Question: In a single sentence, describe what this figure presents.
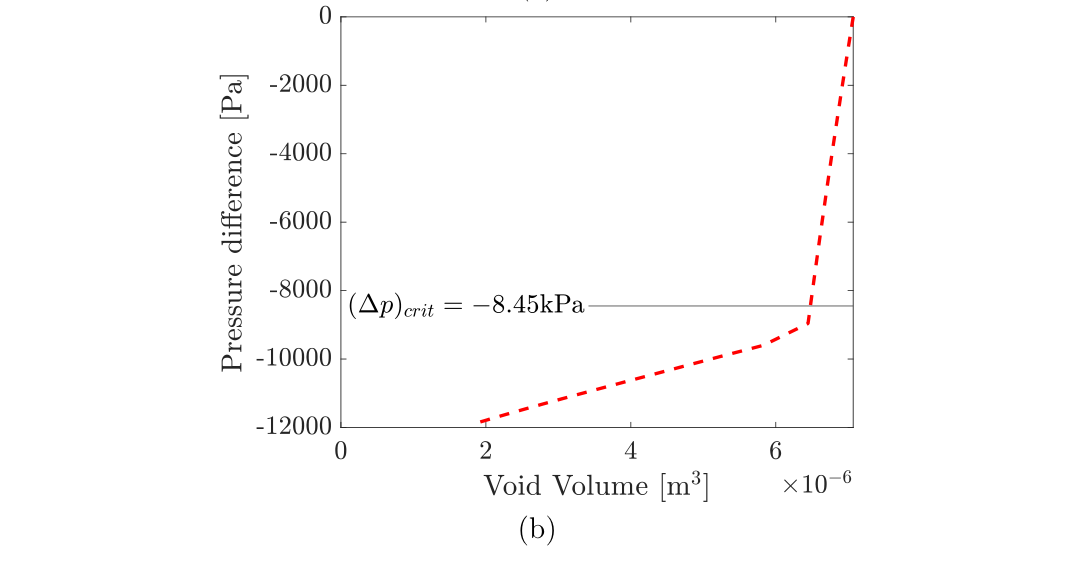
Answer: Simulation and experimental data of a pneumatically actuated sample of a pattern- forming metamaterial. (a) Comparison of the deformed states from simulation and experiment for various levels of internal pressure loading. (b) A corresponding pressure-volume diagram, with an apparent point of internal instability. The horizontal line highlights the experimentally determined buckling pressure of (∆p)crit = −8.45 kPa.